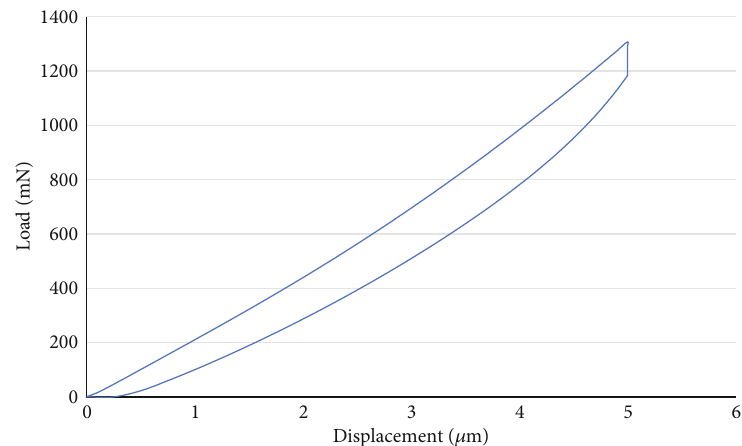
Figure 7: Schematic of the load-displacement curve for the coating/substrate system during the nanoindentation.